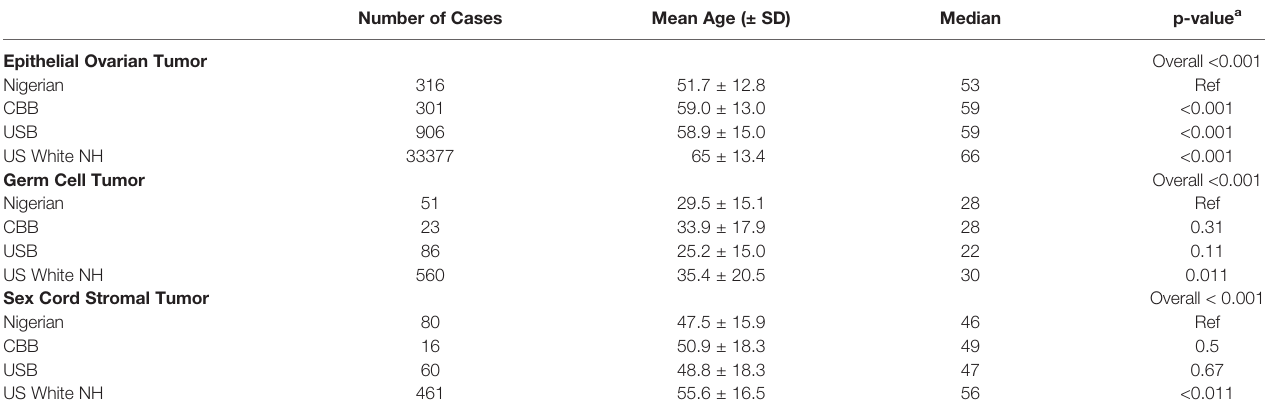
TABLE 1 | Distribution by age at diagnosis and ovarian histotype across